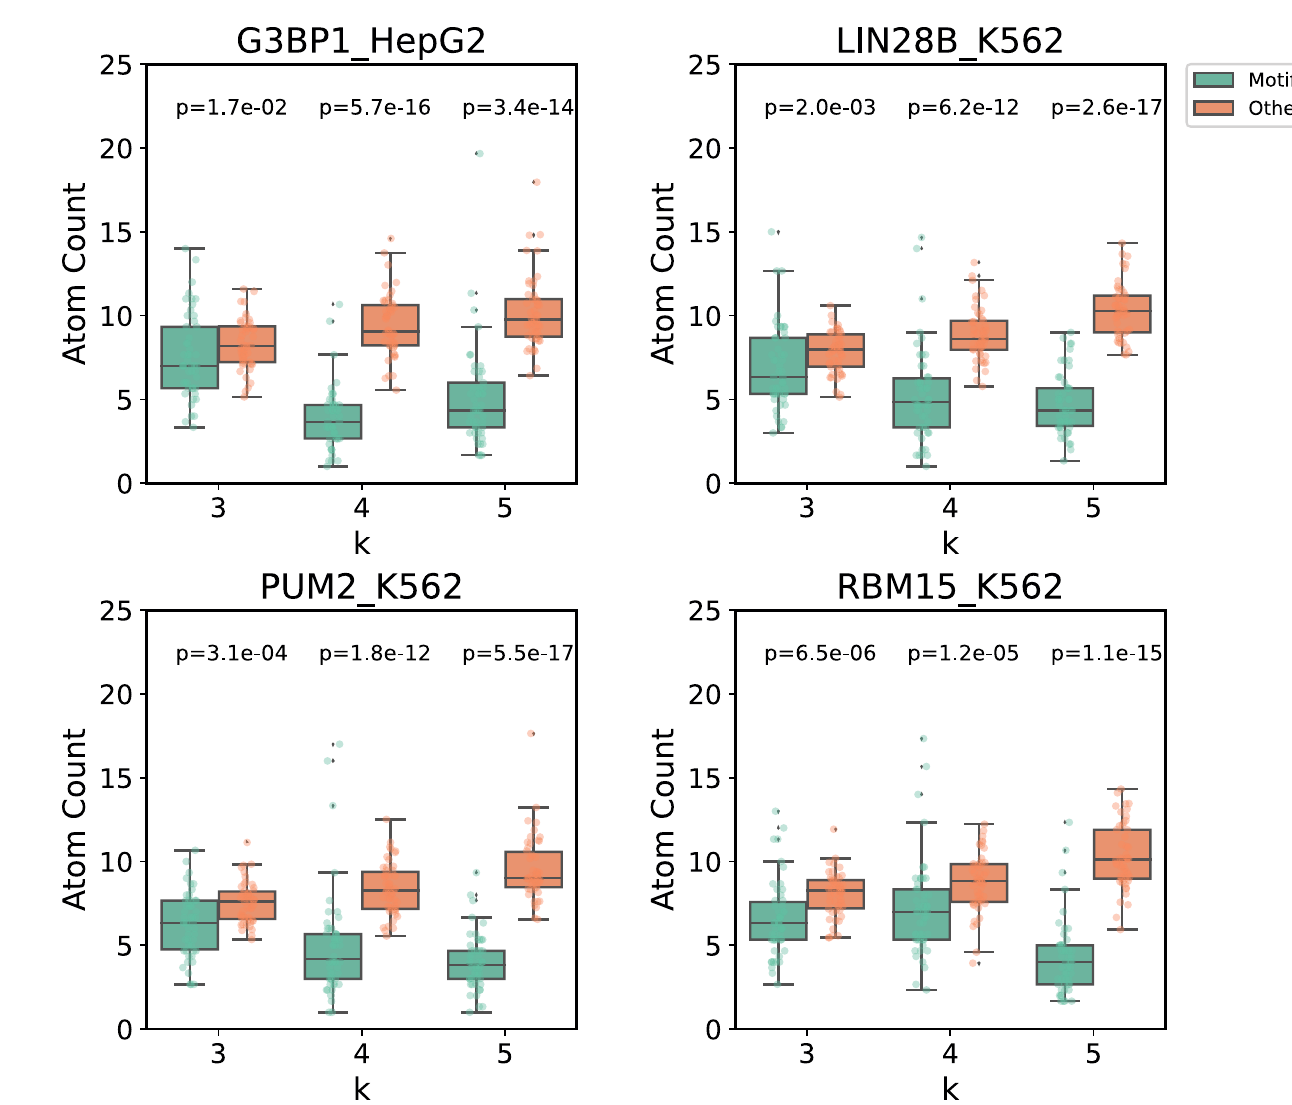
Fig 6. Boxplots of average atom counts calculated from DMD modeled 3D structures of discovered RNA network motifs and other regions of the RNA.